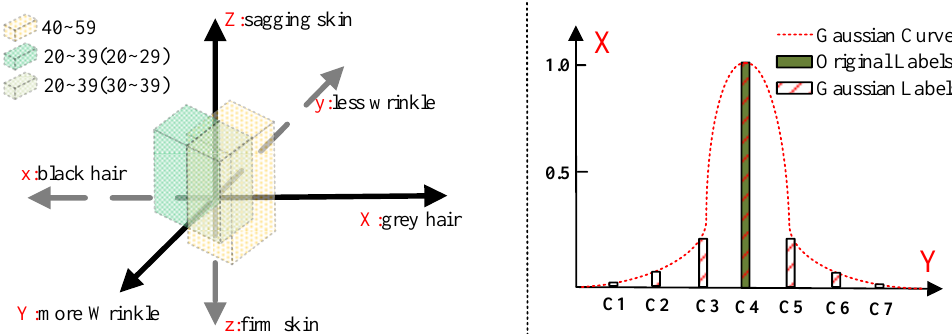
Figure 3. The left panel presents an example that shows overlapping features between two neighbor groups. The right panel shows the one-hot labels and the Gaussian processed